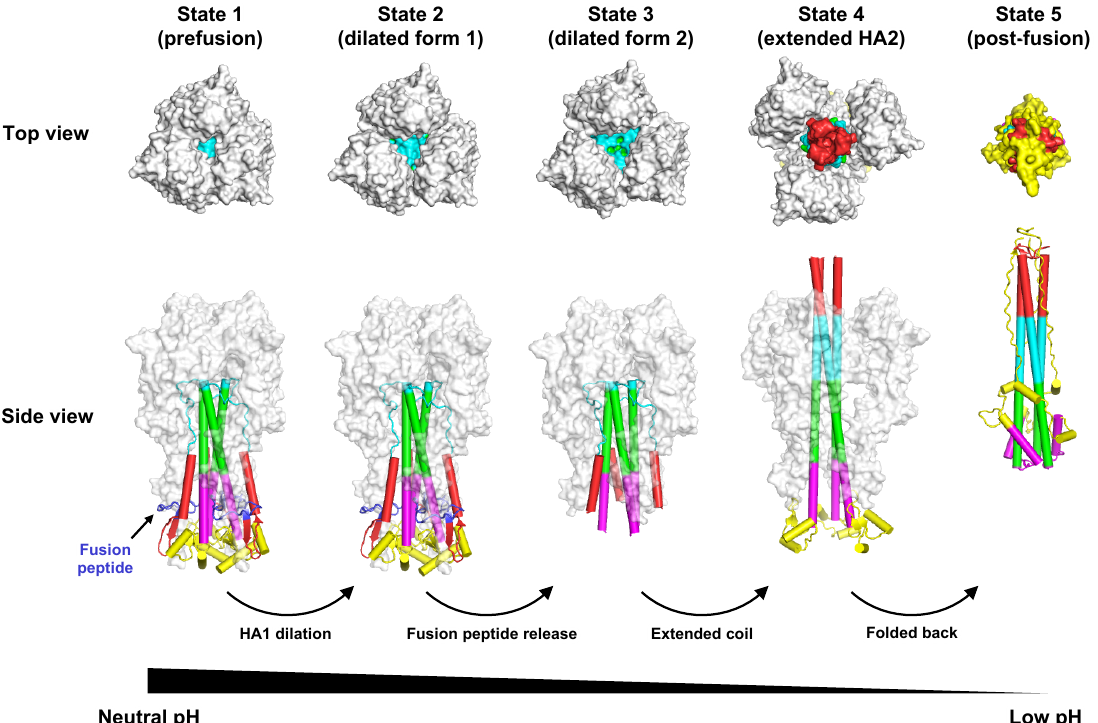
Figure 2. Conformational change of HA during pH-induced membrane fusion. Di ff erent intermediates states of HA during pH-induced conformational change were identified by cryo-EM [60]. The top and side views of state 1 (prefusion conformation, PDB 6Y5H) [60], state 2 (dilated form 1, PDB 6Y5I) [60], state 3 (dilated form 2, PDB 6Y5J) [60], state 4 (extended HA2, PDB 6Y5K) [60], and state 5 (post-fusion conformation, PDB 1QU1) are shown [61]. Of note, after fusion peptide is released from state 2, the fusion peptide becomes disordered [60]. In state 3, the membrane proximal region (yellow) is also disordered [60]. Di ff erent components in the HA2 that are involved in structural rearrangements between pre- and post-fusion structures are in di ff erent